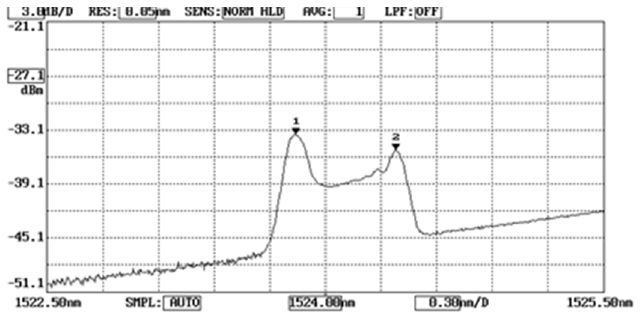
Figure 7. Optical spectrum reflected from the unbonded and bonded FBG subjected to a mechanical loading of 157 N at a temperature of 47 °C.